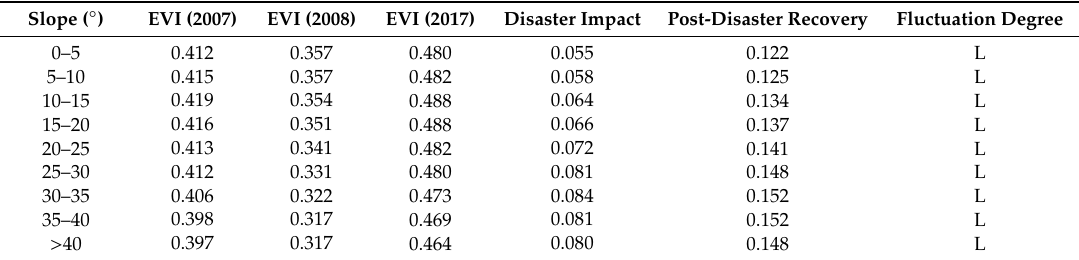
Table 6. Details of the disaster impact and post-disaster recovery in di ff erent slope zones.